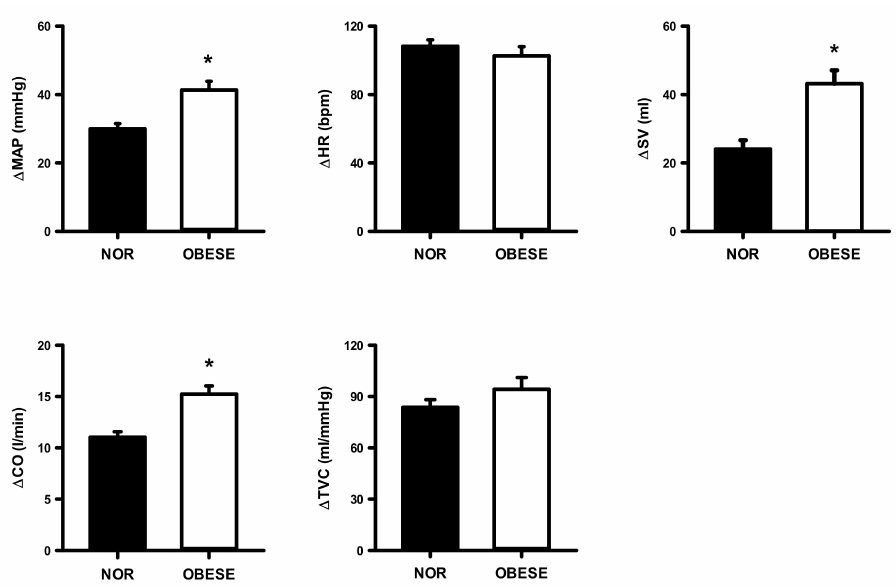
Figure 9. Changes from rest in mean arterial pressure (MAP), heart rate (HR), stroke volume (SV), cardiac output (CO), and total vascular conductance (TVC) during the 80% of VO 2peak workload in normal and obese individuals. Black bar, normal; open bar, obese. * p < 0.05, vs. normal